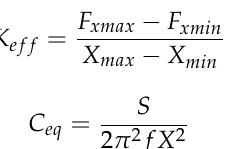
Figure 9. Force–displacement hysteresis loops.